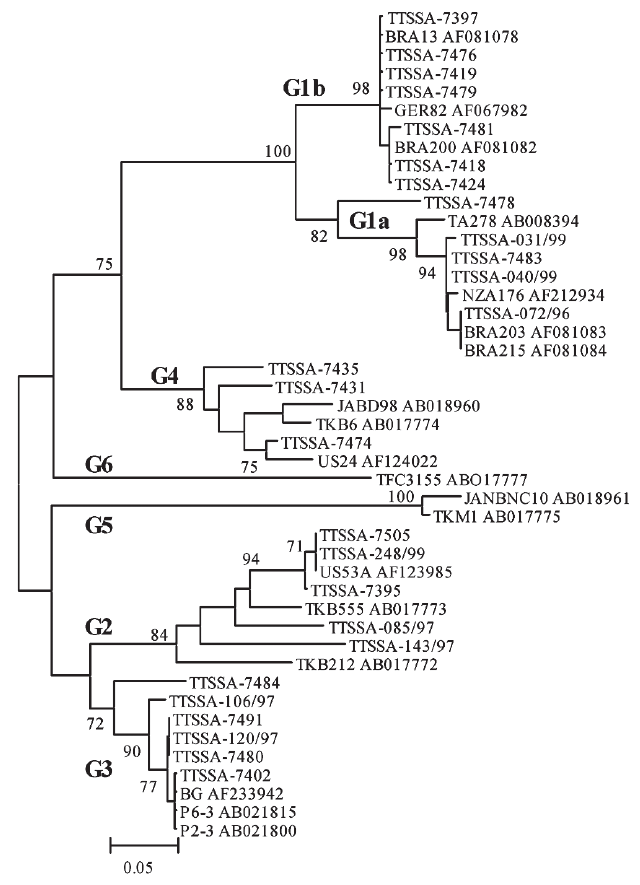
Figure 2. Neighbor-joining tree of 183 nt fragments of TTV. This corre- sponds to nt 1960-2142 of strain TA278 from previously published refer- ence strains and from our study population. For previously published reference strains, the GenBank accession numbers are indicated. The genotype designations used correspond to designations from previous publications. They are indicated on the branches. The bootstrap test of phylogeny was performed with 1000 replicates and values equal to or higher than 70 are